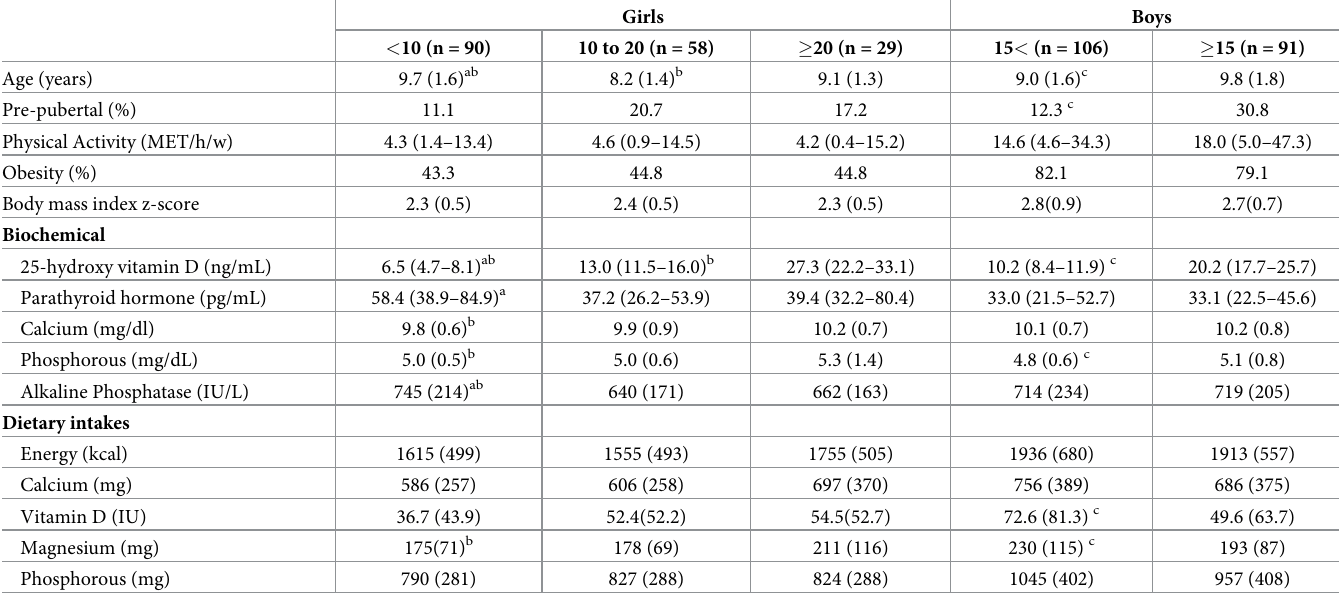
Table 2. Characteristics of study participants based on threshold of 25(OH)D concentration (ng/mL).